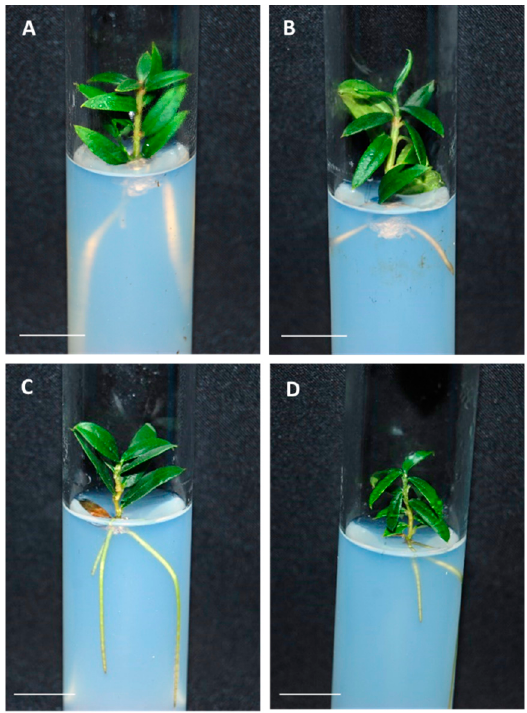
Figure 5. Rooting of olive shoots derived from ( A , C ) control and ( B , D ) cryopreserved embryogenic cultures of the lines T1 ( A , B ) and P5 ( C , D ). Bar = 1 cm.